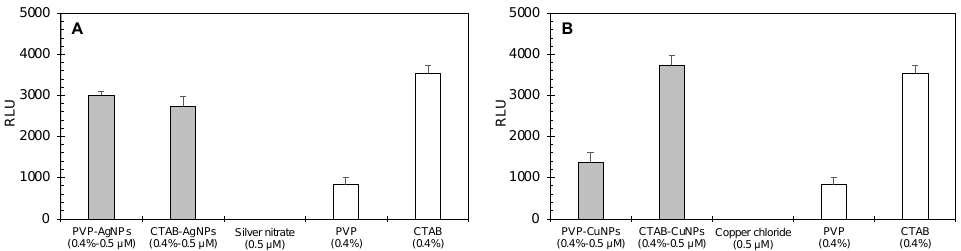
Figure 4. Effects of nanoparticle systems on ROS generation by E. coli bacteria cells exposed to surface-coated nanoparticles and their component chemicals. Panels show the relative luminescence units resulting from the ROS-Glo™ H 2 O 2 Assay of E. coli cells exposed to ( A ) surface-coated silver nanoparticles and their components and ( B ) surface-coated copper nanoparticles and their components. Error bars depict one standard deviation from the mean. The assay was validated using menadione as a positive control for ROS production in bacterial cells; its RLU value was 3650.